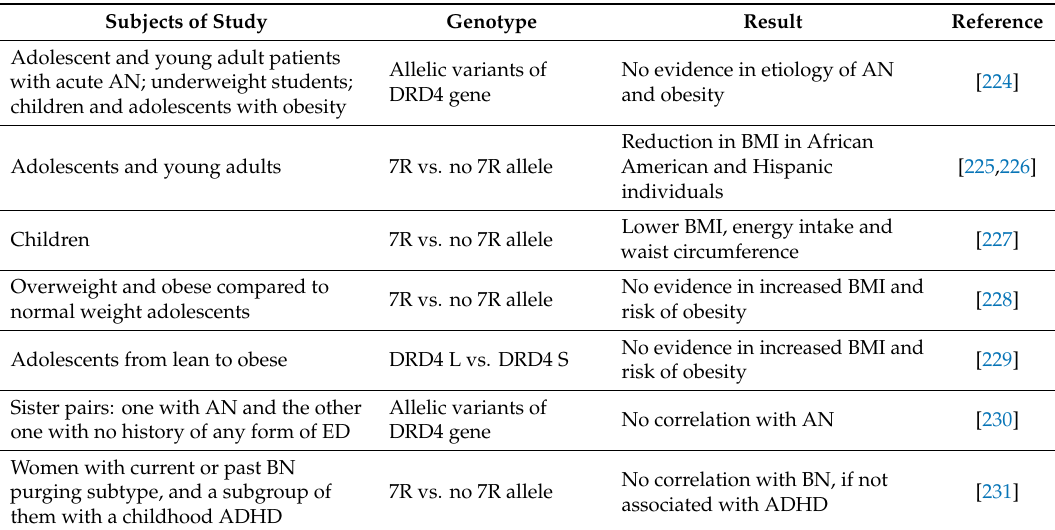
Table 3. The e ff ect of the 7R or longer allele (DRD4 L) in eating